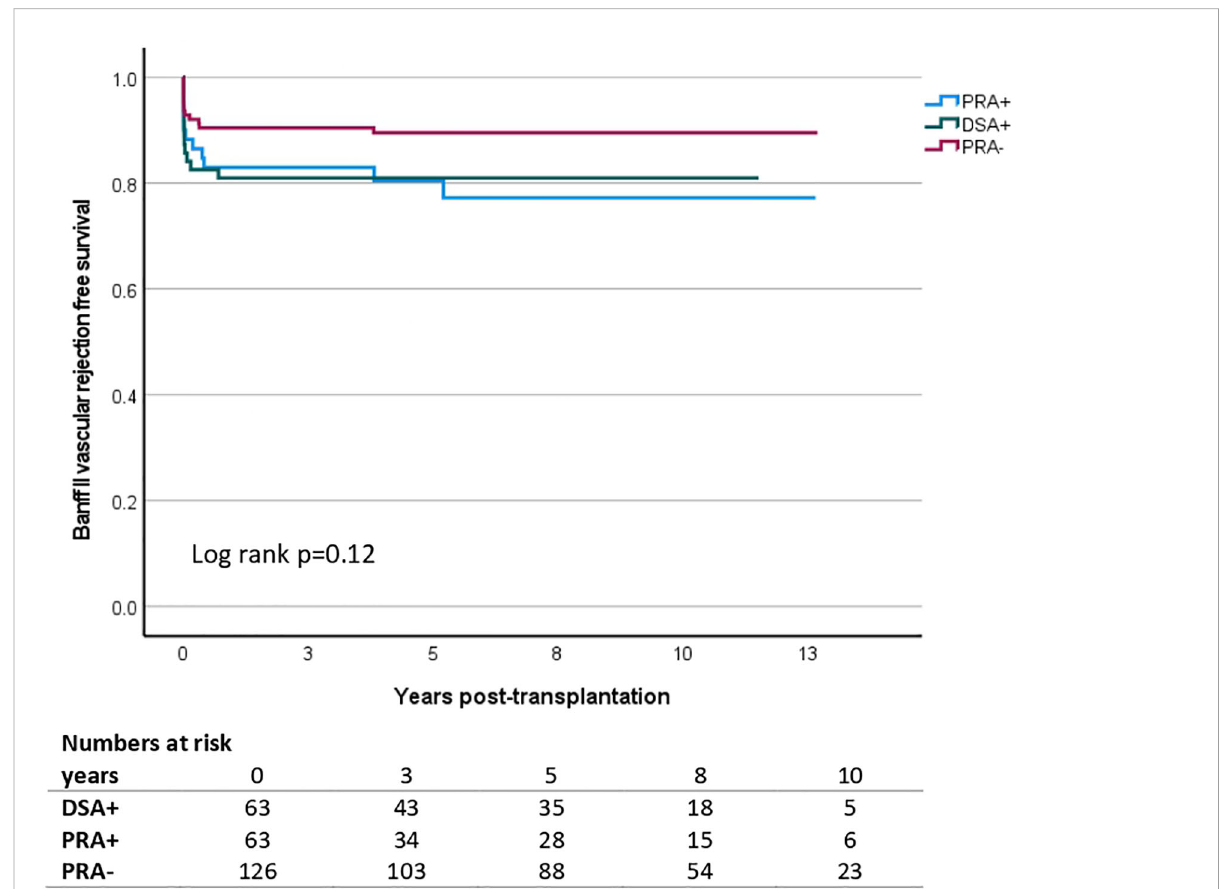
FIGURE 3 Kaplan Meier survival analysis of acute cellular Banff type II vascular rejection in living donor kidney transplantation according to the presence and type of pretransplant anti-HLA antibodies. A comparison made is across donor-speci fi c antibody (DSA)-positive individuals (DSA+, n=63), highly immunized individuals (PRA+, n=63) and non-immunized individuals (PRA-, n=126). The y-axis shows the proportion of patients alive with a functioning graft without vascular rejection. The x-axis represents the days